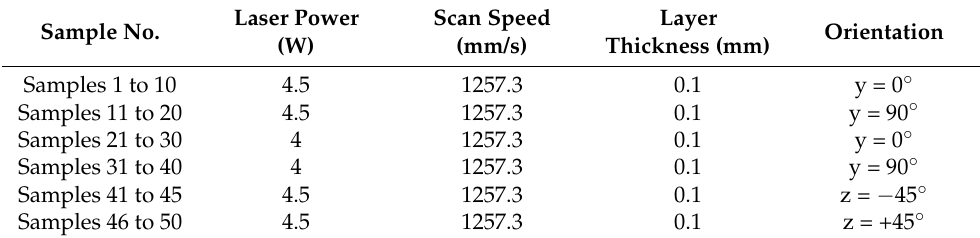
Table 2. SLS process parameters of Compressive test samples.